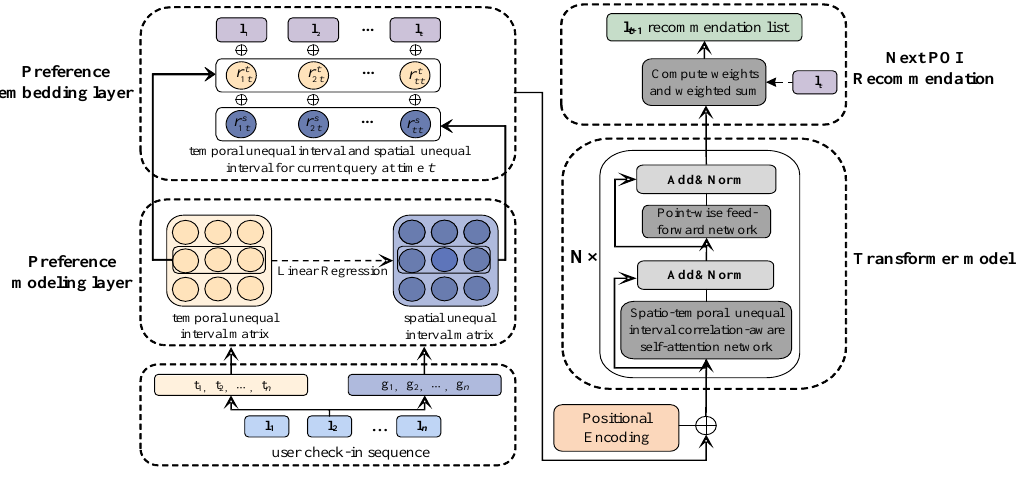
Figure 4. Illustration of STUIC-SAN